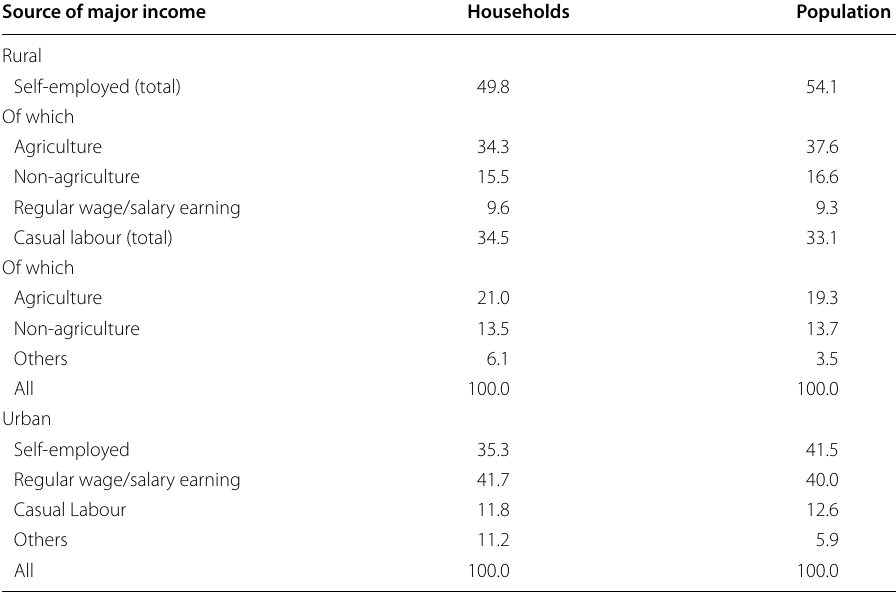
Table 5 Distribution of the households/populations as per major source of income NSSO 68th round. Source: NSSO (2015) Source of major income